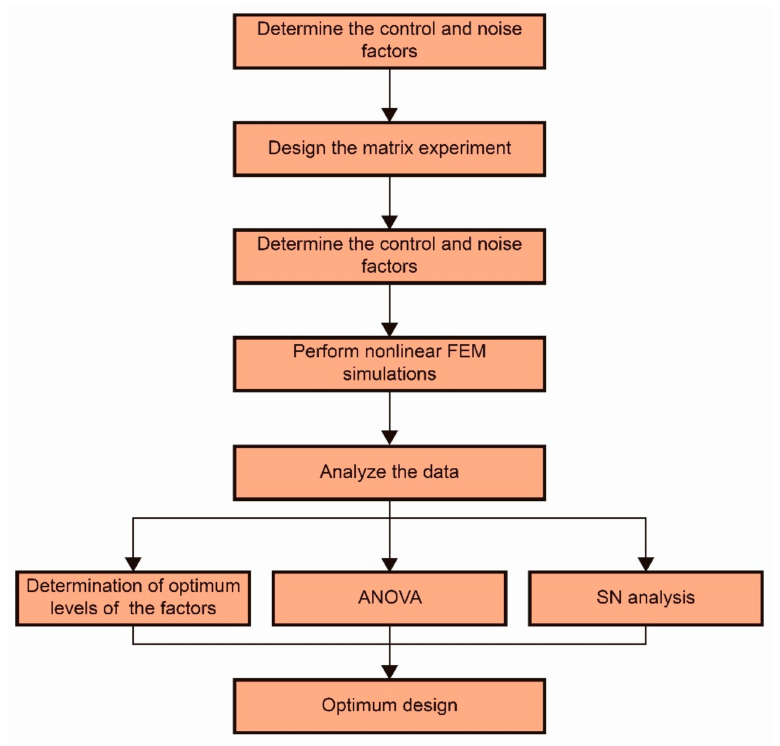
Figure 3. Flowchart followed in the investigation.